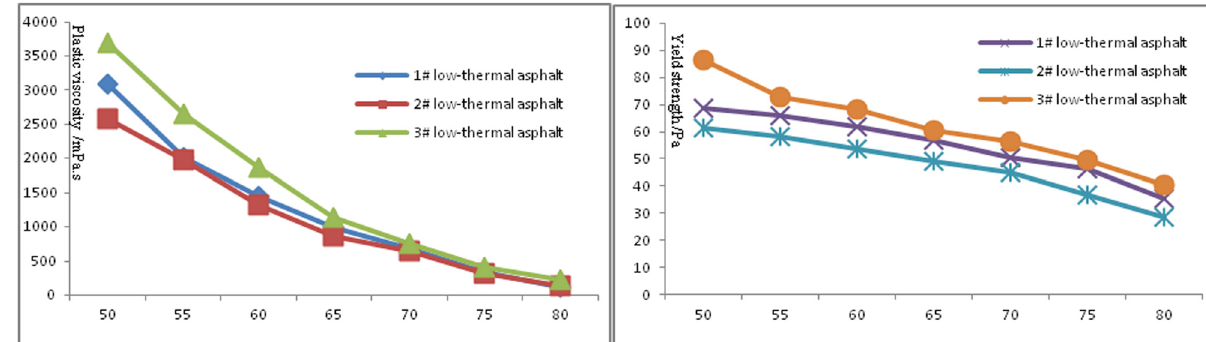
Figure 5: Rheological parameters of low - thermal asphalt at different